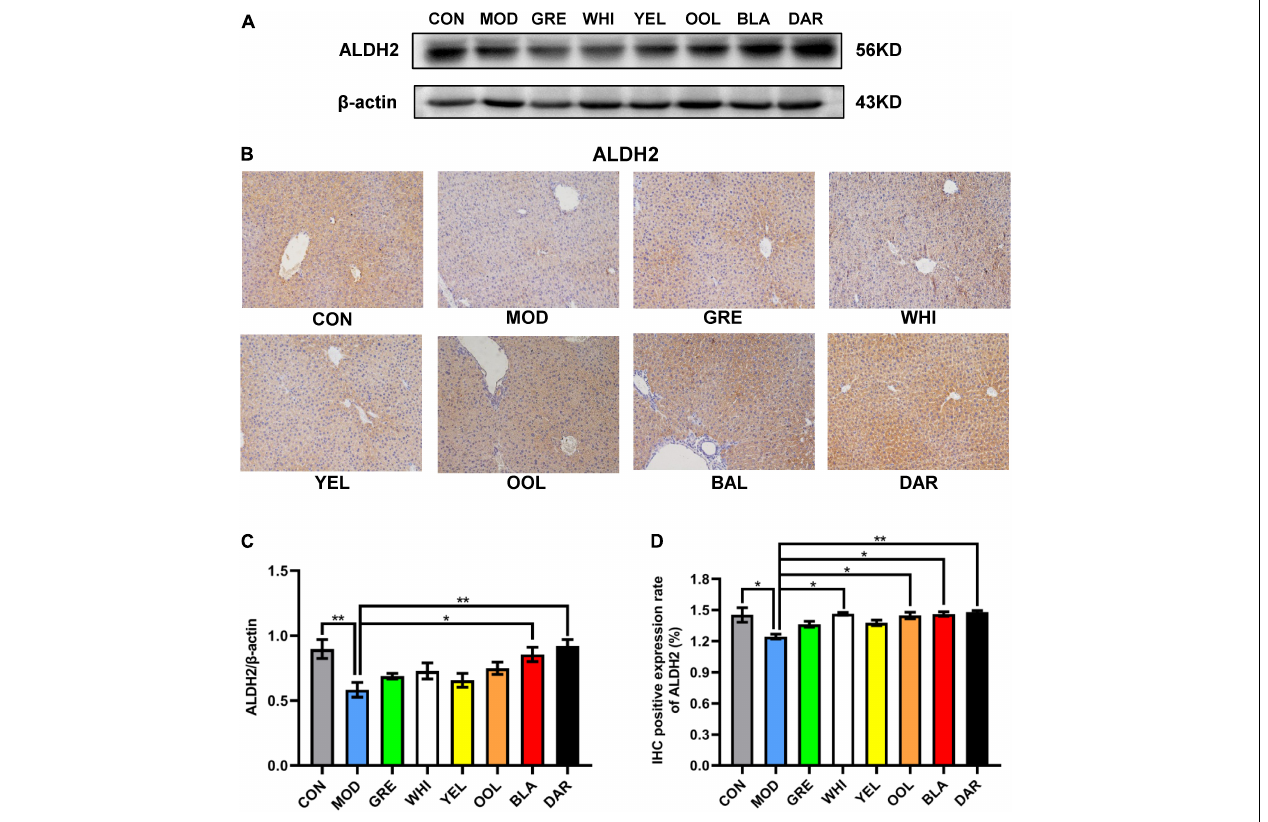
FIGURE 5 | Effects of WEATs on ALDH2 expression in the liver of mice. Representative immunoblots (A) and IHC images (B) of ALDH2 expression in the liver. Quantification of ALDH2 expression by western blotting (C) and IHC (D) . Each value represents the mean ± SEM ( n = 9). * p < 0.05 vs. MOD; ** p < 0.01 vs. MOD.